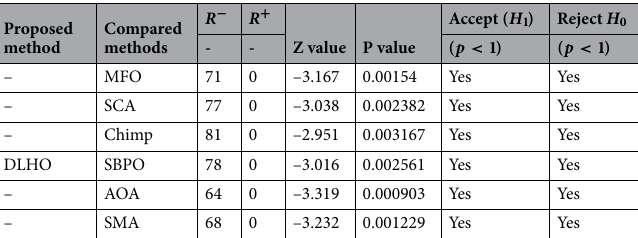
Table 8. Robustness assessment of the algorithms by Wilcoxon